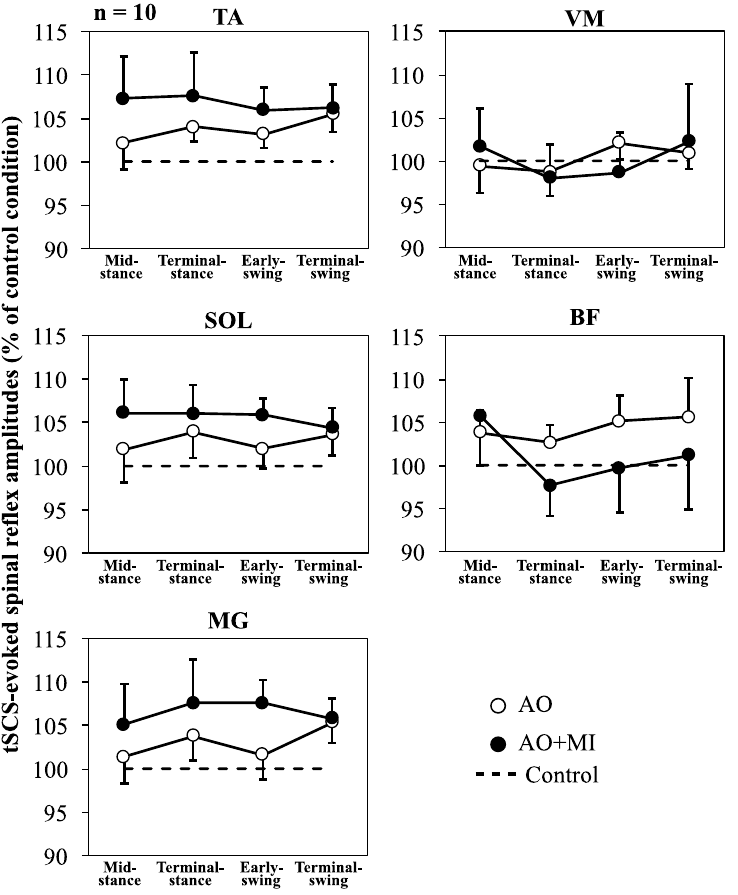
Figure 3. Mean amplitudes ( n = 10) of normalized transcutaneous spinal cord stimulation (tSCS)-evoked spinal reflexes in the tibialis anterior (TA), soleus (SOL), medial gastrocnemius (MG), vastus medialis (VM), and biceps femoris long head (BF) muscles in action observation (AO; open circles) and AO with motor imagery (AO + MI; closed circles) conditions. Error bars represent standard errors of measurement. Dashed lines (100%) indicate baseline value (100%; i.e., tSCS-evoked spinal reflex amplitude under control conditions). There were no significant main e ff ects regarding condition, phase, or their interaction in any of the recorded